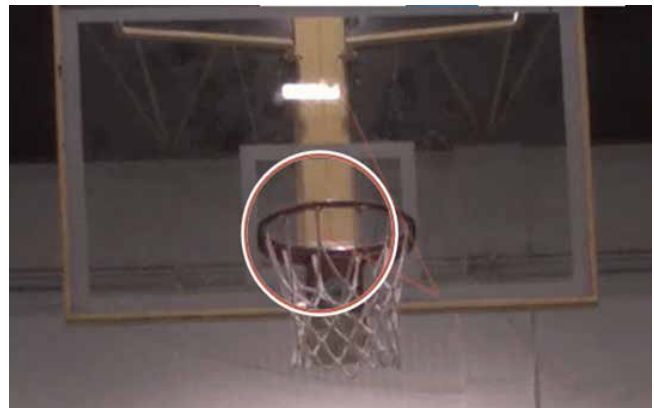
Fig. 2. The Moment of Fixation on the Hoop Taken from the Eye Tracking